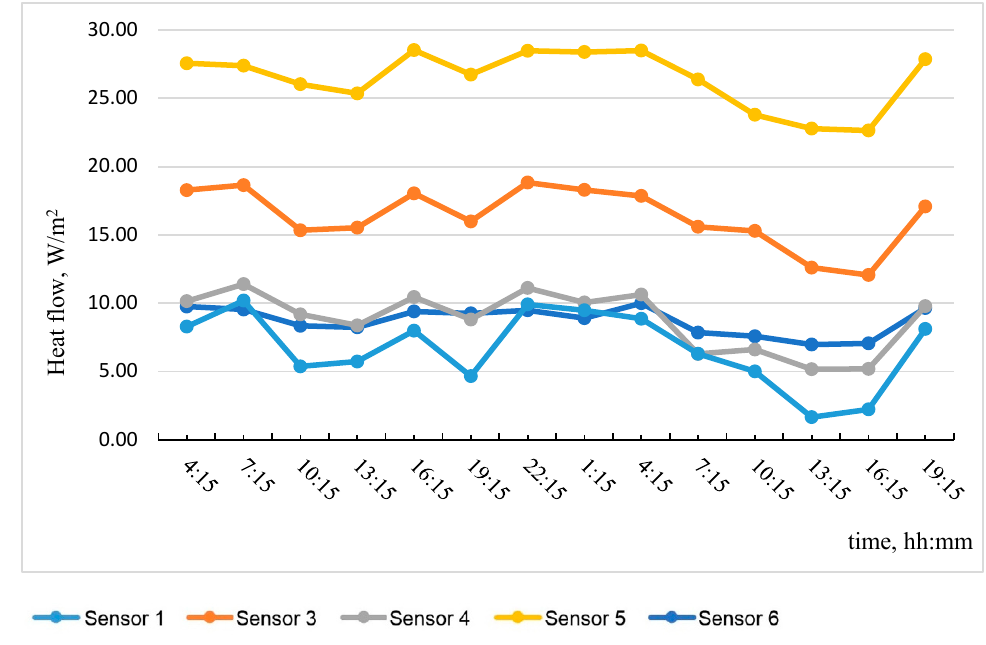
Figure 6. Heat flow dependence on time.